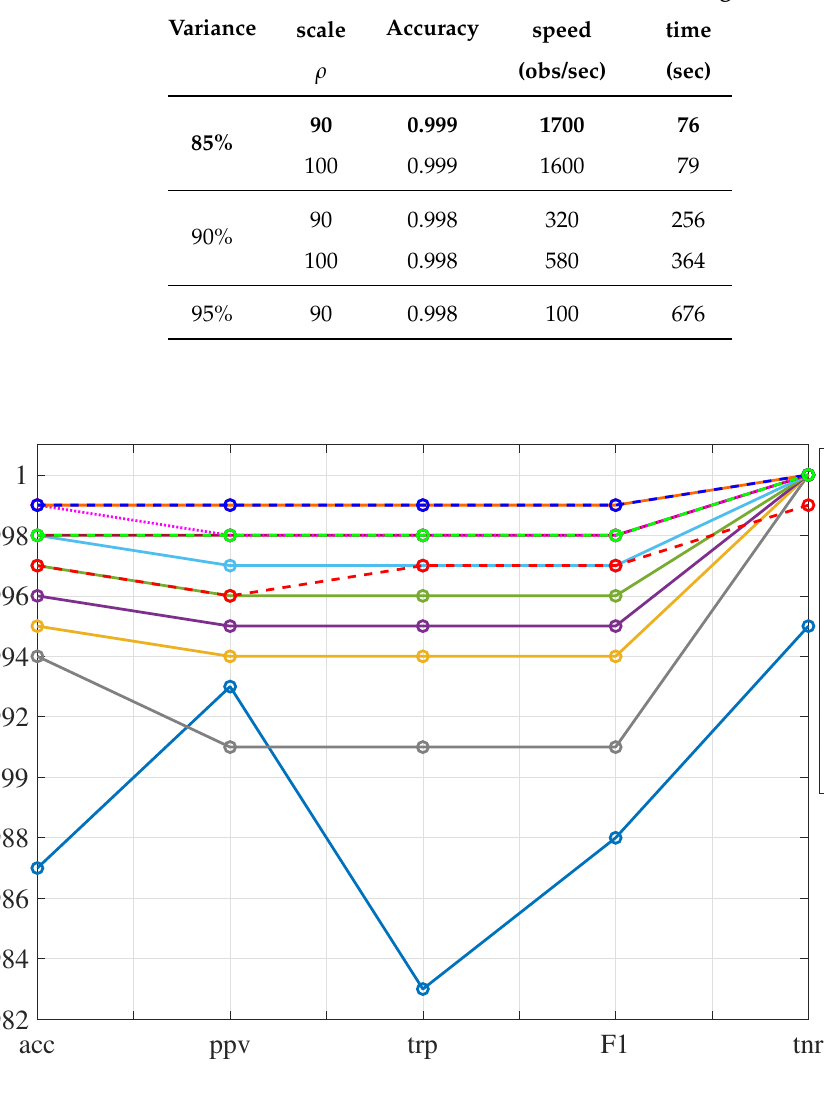
Figure 11. Indicators to evaluate the SVM classification model using 85% of variance. The cases with the best performance are ρ = 90 and ρ = 100 that are represented by the overlapped orange (solid) line and blue (dotted) line, respectively. The graph omits ρ = 300 since the results obtained are much worse and would be out of the y-axis scale used in this